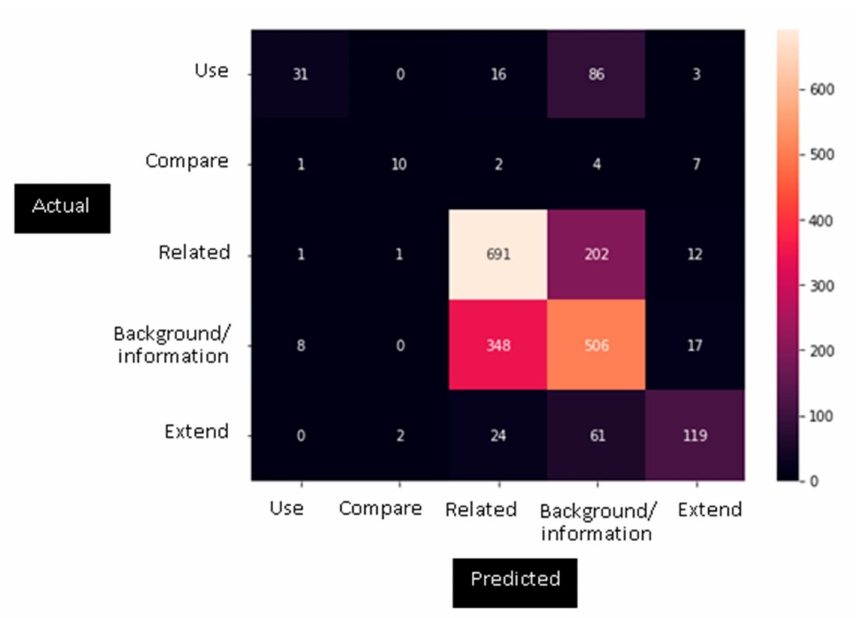
Figure 2. Configuration